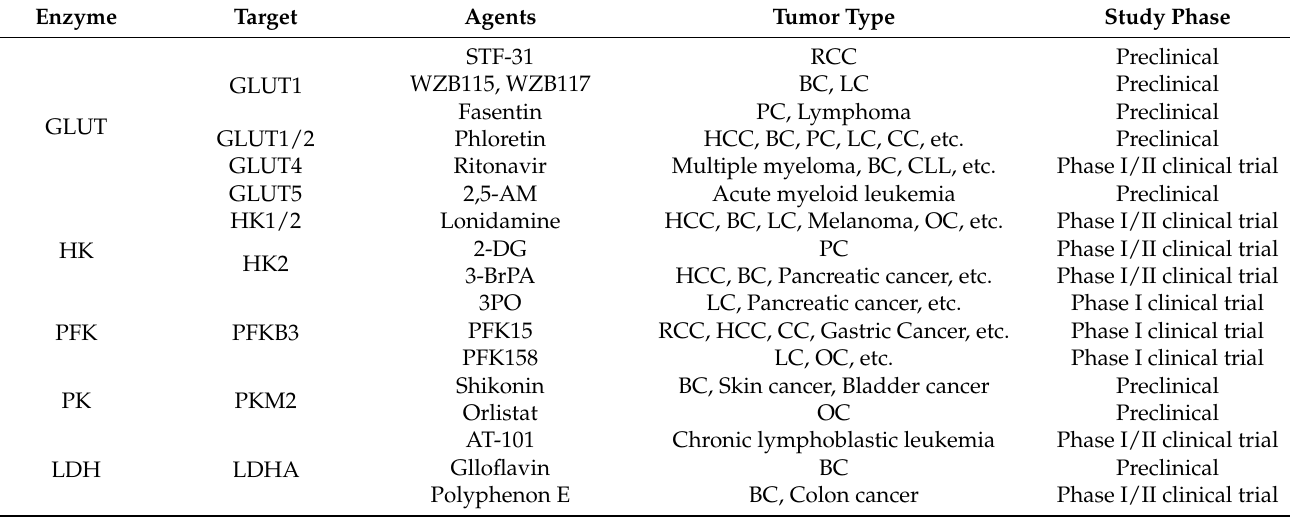
Table 1. Main targets and drugs of glucose metabolism of cancer